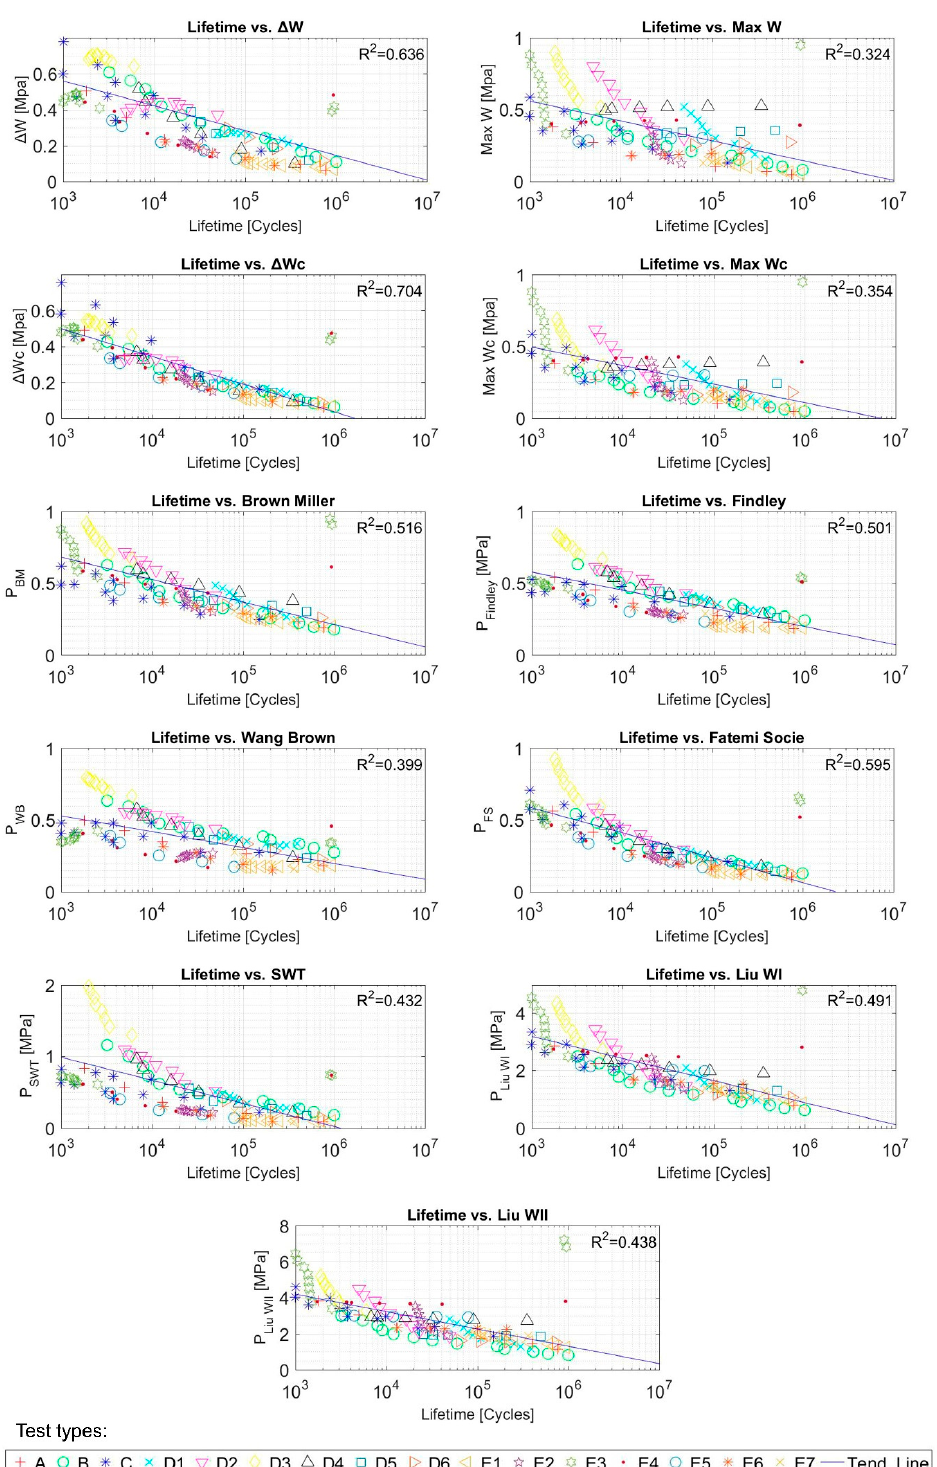
Figure 11. Fatigue parameters and tests lifetime (cycles) correlation for SBR tests. Initial data from [46]